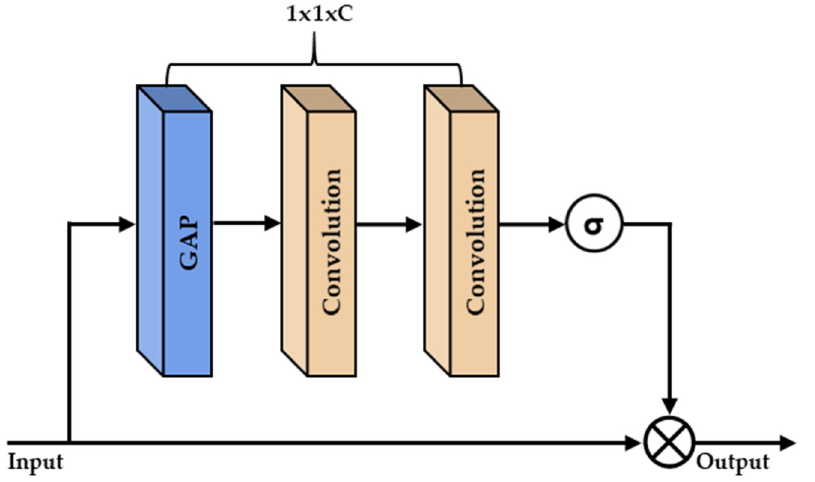
Figure 3. The architecture of a CA-block. ‘ σ ’ and ‘ ⊗ ’ indicate sigmoid function and channel-wise product, respectively.